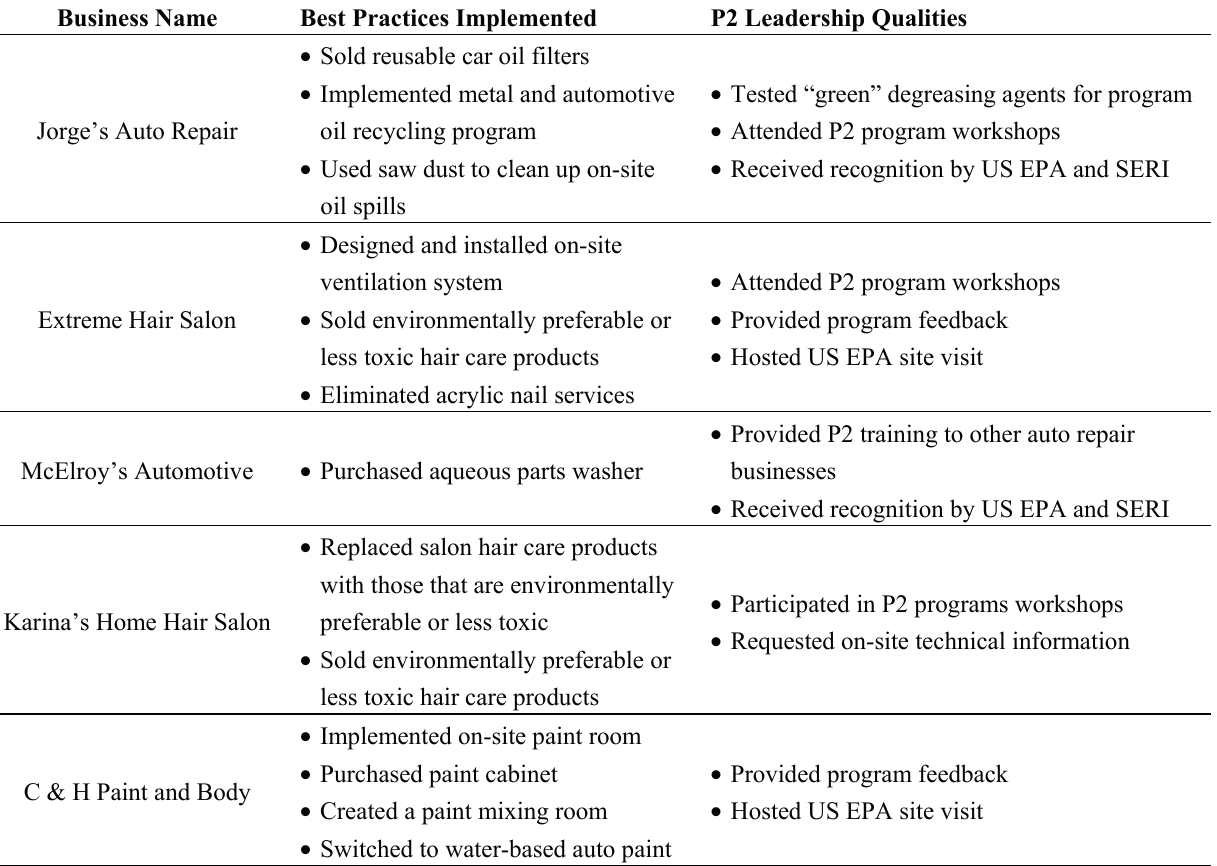
Table 2. Examples of P2 business leadership identified as a result of the promotora-led P2 program. Business